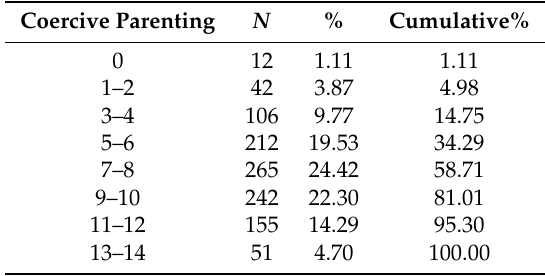
Table 2. Type of coercive parenting experienced by the